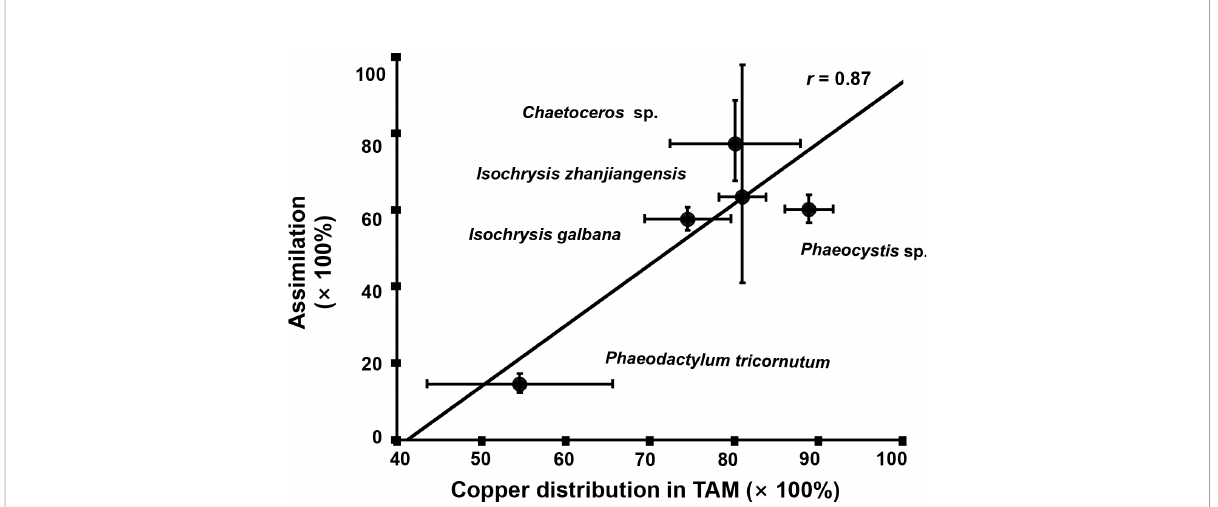
FIGURE 6 The relationship between Cu assimilation ef fi ciencies (AEs) in rotifer after feeding different phytoplankton species and the Cu distribution in the trophically available metal fraction (TAM) in the respective phytoplankton